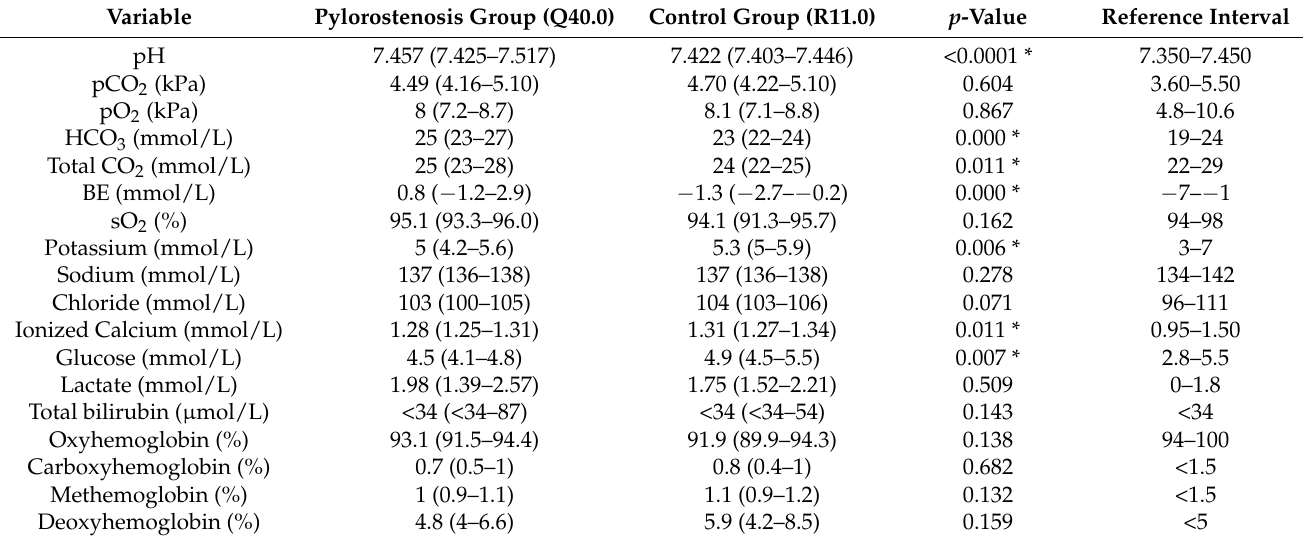
Table 2. Comparison of acid-base status between